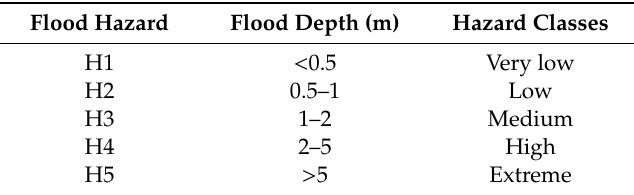
Table 1. Flood hazard classification according to MLIT [2].